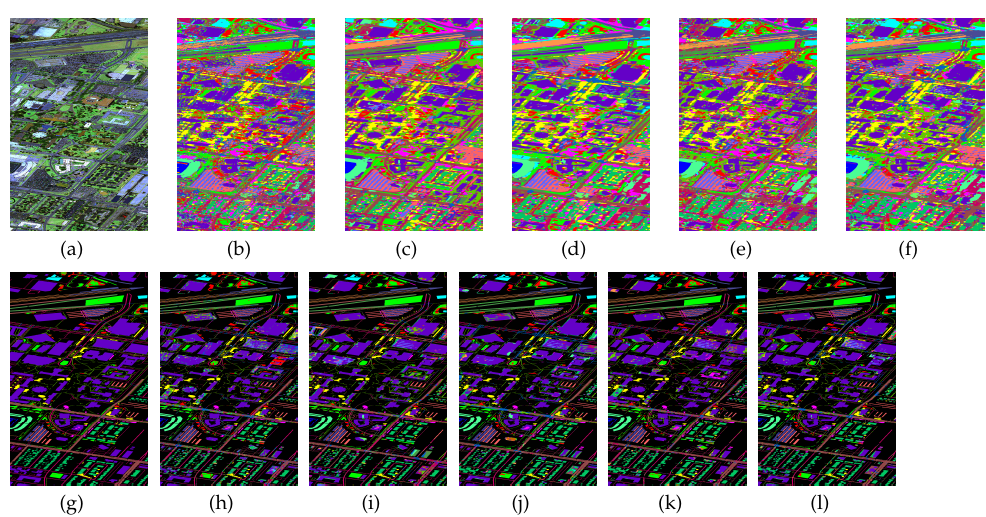
Figure 5. Classification maps generated by all of the competing methods on the University of Houston data with 2000 training samples. ( a , g ) are false-color images and ground-truth maps, respectively, while ( b – f ) and ( h – l ) are the results of HybridSN, SSRN, A-SPN, MCNN-CP, and Oct-MCNN-HS, respectively.